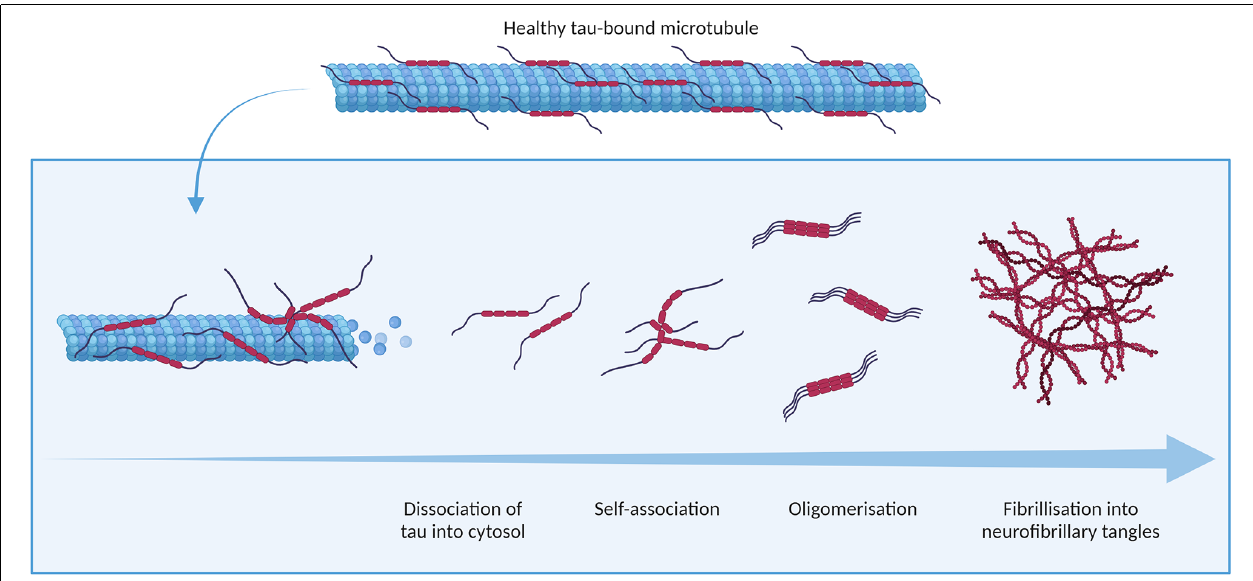
FIGURE 3 | Tauopathy in Alzheimer’s